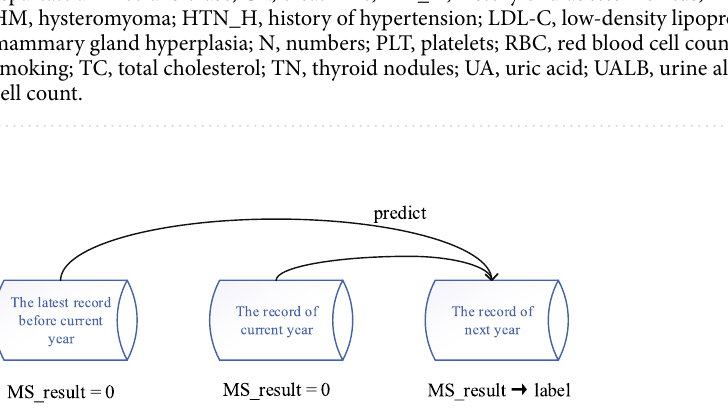
Figure 3. Schematic diagram of the risk prediction model for MetS within the next 1